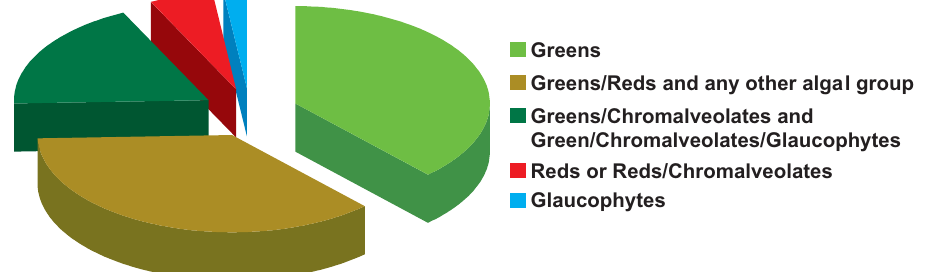
Figure 1. Pie chart showing the distribution of Chlamydiae-like genes among Plantae and chromalveolates. doi:10.1371/journal.pone.0002205.g001 PLoS ONE |